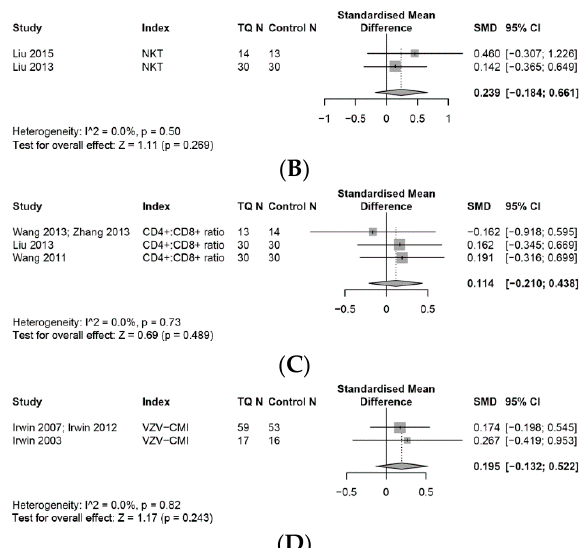
Figure 4. Forest plot for random-effects meta-analysis of the effects of TQ on the adaptive immune system. ( A ): The effects on the adaptive immune system, ( B ): the effects on the NKT cells, ( C ): the effects on the CD4+/CD8+ ratio, ( D ): the effects on the VZV-cell-mediated immunity.